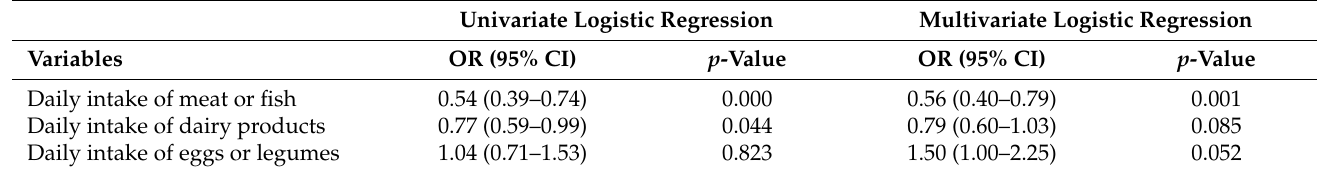
Table 2. Cont. Univariate Logistic